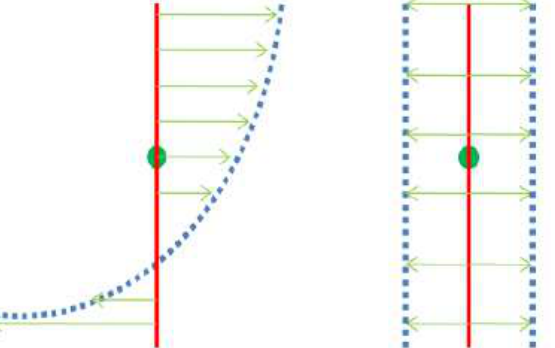
Figure 1: Categorize point clouds of curved structures as roofs (left) or cylinders (right) by examining the vertical distribution of points.